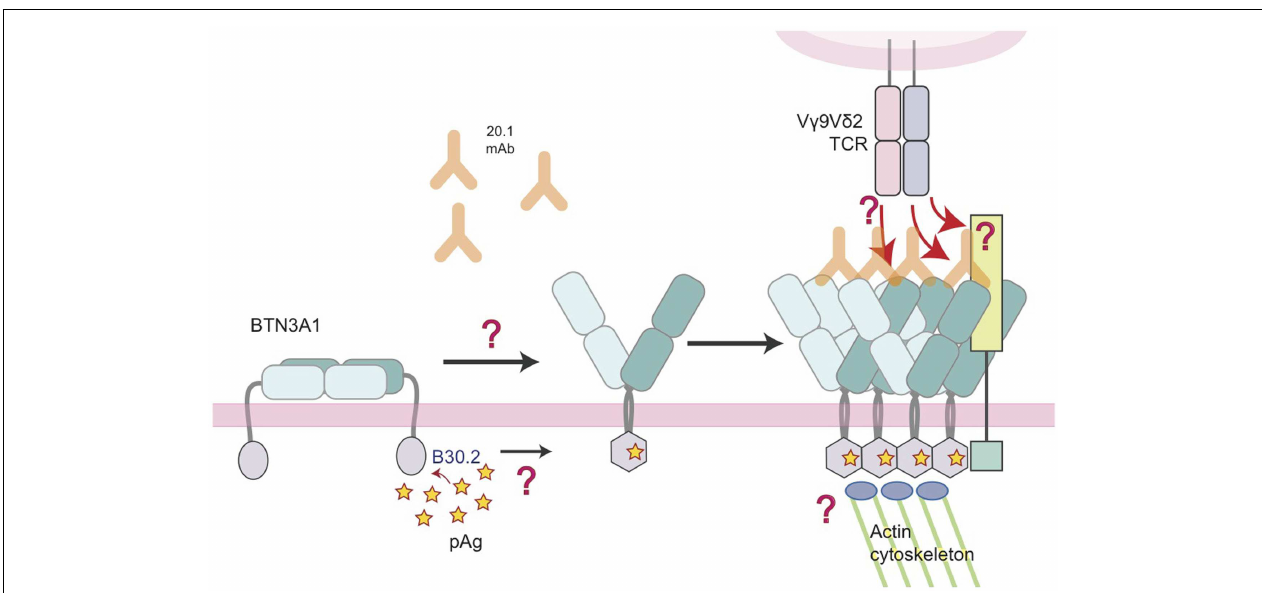
undergoes a conformational change upon pAg binding (hexagonal shape).This conformational change induces structural reorganization of BTN3A molecules, either via immobilization through B30.2 association with the actin cytoskeleton or B30.2 multimerization of BTN3A molecules, which is then signaled by an inside-out mechanism to change the architecture of the BTN3A extracellular domains.This architectural change could alone be the signal that V γ 9V δ 2TCRs recognize, or recruitment of an additional, human-specific accessory molecule (lime-green square) occurs, which directly engages the V γ 9V δ